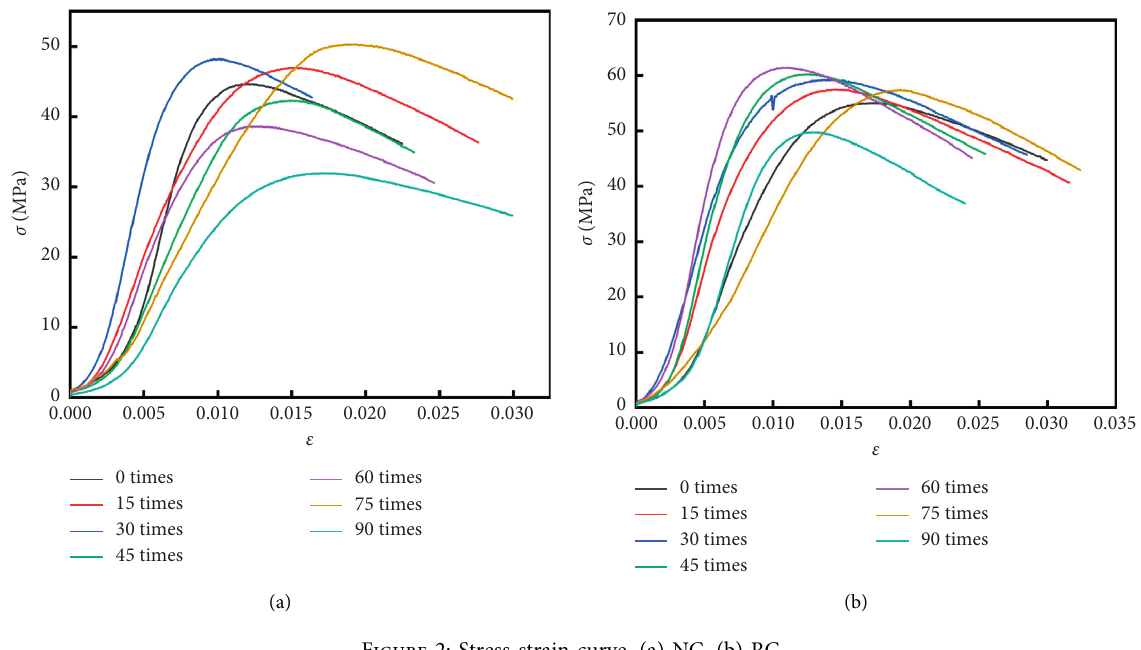
Figure 2: Stress-strain curve. (a) NC. (b)